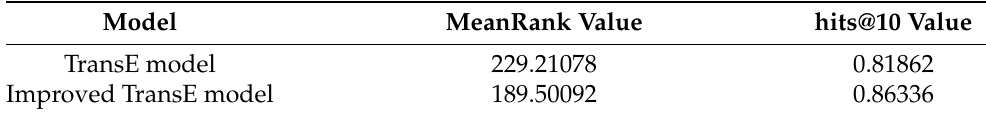
Table 2. Comparison of MeanRank value and hit@10 value before and after improvement.